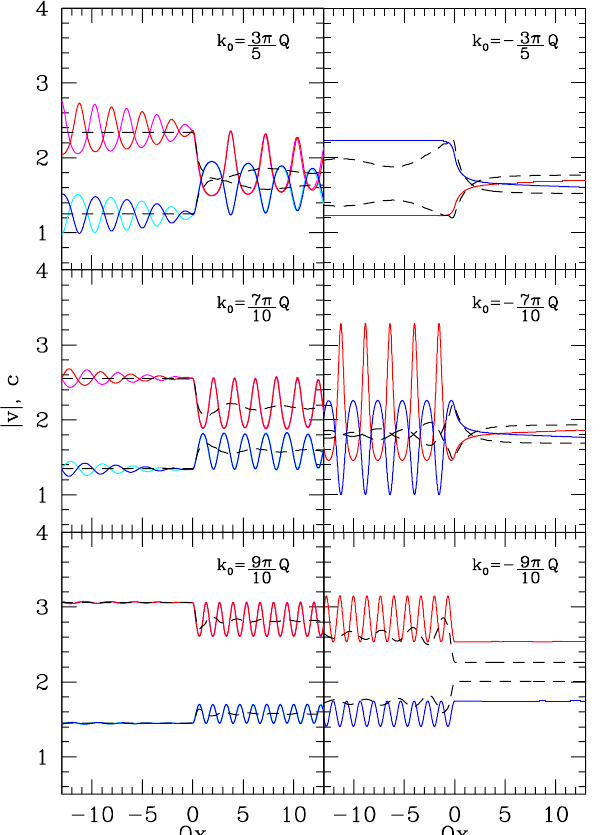
Figure 10. Absolute value of the fluid velocity (red) and of the sound speed (blue) according to the Q and different values of k 0 . Left GPE dynamics. The initial state is a homogeneous fluid with k F = π 2 panels correspond to a left moving fluid ( k 0 > 0), right panels to right moving fluid ( k 0 < 0, i.e., against the step). Velocities are in unit of ¯ hQ . The snapshots are taken at a time t = 60 m for the right moving m ¯ hQ 2 cases, where the GPE slowly drives the system towards a stationary state. For a left moving fluid, the snapshots correspond to t = 15 m . In these cases, the system reaches a steady state in the upstream ¯ hQ 2 region, while the velocity profiles oscillate in time (and space) downstream. Snapshots taken at a time t = 14 m are also shown (magenta and cyan lines) to emphasize the temporal oscillations. The black ¯ hQ 2 dashed line represents the stationary state reached by the exact evolution in each